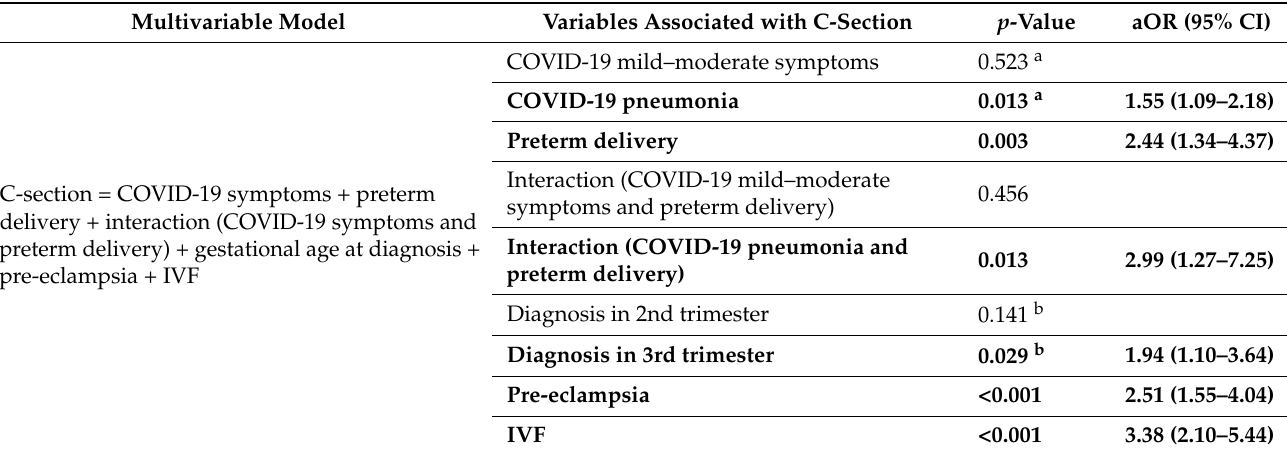
Table 5. Multivariable analysis of the C-section